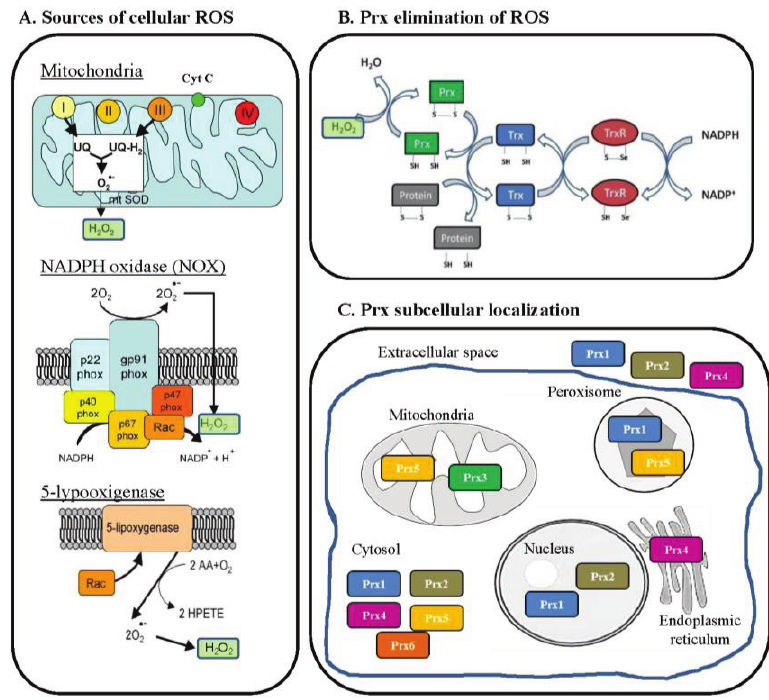
Figure 1. Aspects related with peroxiredoxins and the metabolism of reactive oxygen species (ROS). ( A ) Major sources of H 2 O 2 are mitochondria, the NADPH oxidase (NOX) complex of phagocytic cells, and 5-lipoxygenase (reviewed by [2]). In the mitochondria, electrons from the electron transport chain are used to form O 2 − at the level of complex I and III, before being converted by mitochondrial superoxide dismutase (SOD) into H 2 O 2 , which can cross mitochondrial membranes to reach the cytoplasm. Regarding the NOX complexes, they are present in both professional phagocytic cells (macrophages, neutrophils, and eosinophils) and non-phagocytic cells and play a crucial role in different diseases. The NOX of non-phagocytic cells is constitutively active, producing a very low level of ROS and increasing both its activity and ROS generation in response to a number of factors and conditions. Finally, 5-lipoxygenase (5-LOX) is a mixed function oxidase involved in the synthesis of leukotrienes from arachidonic acid in response to essentially the same stimuli that are able to stimulate NOX, particularly growth factors and cytokines. The last mediators lead to membrane ruffling and the generation of superoxide, and then H 2 O 2 , through the intervention of the small GTPase Rac1 and a SOD isoform. ( B ) Mechanism of action of the thioredoxin (Trx) redox system (reviewed by [3]). Reduced Trx catalyses the reduction of disulfides (S-S) within oxidized cellular proteins, such as peroxiredoxin (Prx). In this process Trx becomes oxidized, is then reduced by thioredoxin reductase (TrxR) at the expense of NADPH. ( C ) Regarding their localization, Prx proteins can be nuclear (Prx1 and Prx2), mitochondrial (Prx3 and Prx5), peroxisomic (Prx1 and Prx5), located in the endoplasmic reticulum (Prx4), cytosolic (Prx1, Prx2, Prx4 – 6), or extracellular (Prx1, Prx2 and Prx4). Cyt C, cytochrome C; UQ, coenzyme Q or ubiquinone; mtSOD, mitochondrial superoxide dismutase; NADP + , nicotinamide adenine dinucleotide phosphate; NADPH, reduced NADP + ; phox, phagocyte oxidase; Rac, Ras-related C3 botulinum toxin substrate; AA, arachidonic acid; HPETE, hydroperoxyeicosatetraenoic acid; Prx, Peroxiredoxin; Trx, Thioredoxin; TrxR, Thioxiredoxin reductase. Modified from [2 –